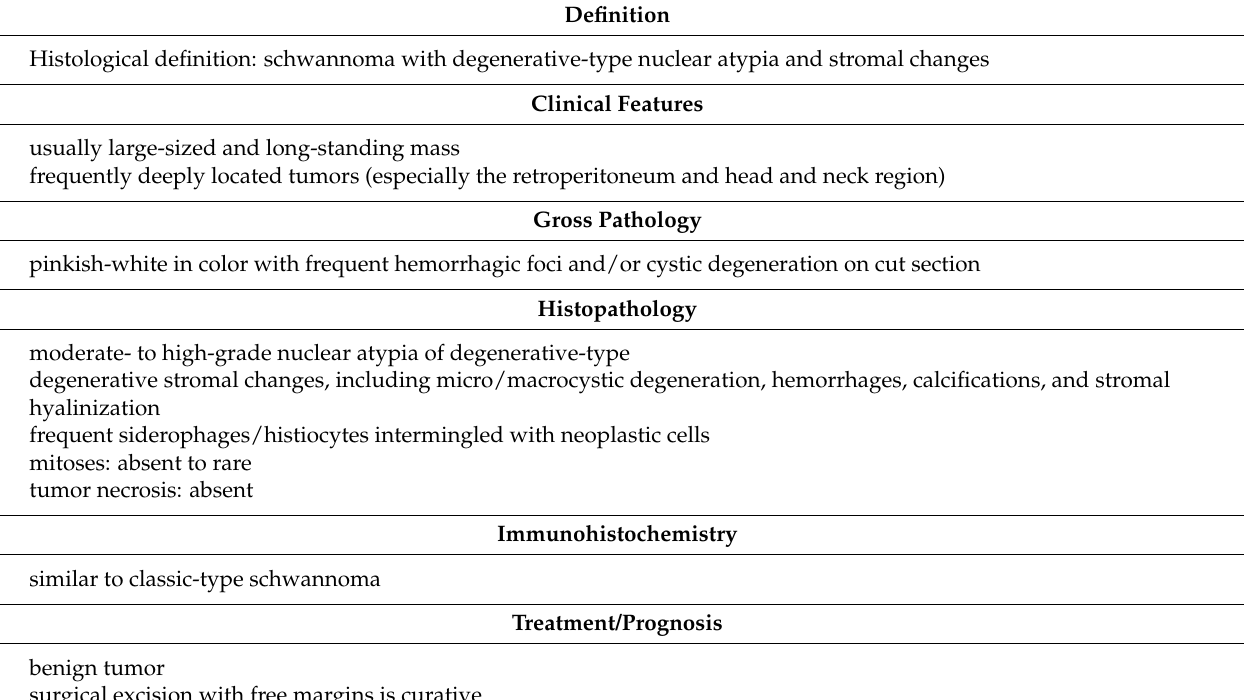
Table 9. Key diagnostic features of schwannoma with degenerative/ancient changes (“ ancient schwannoma